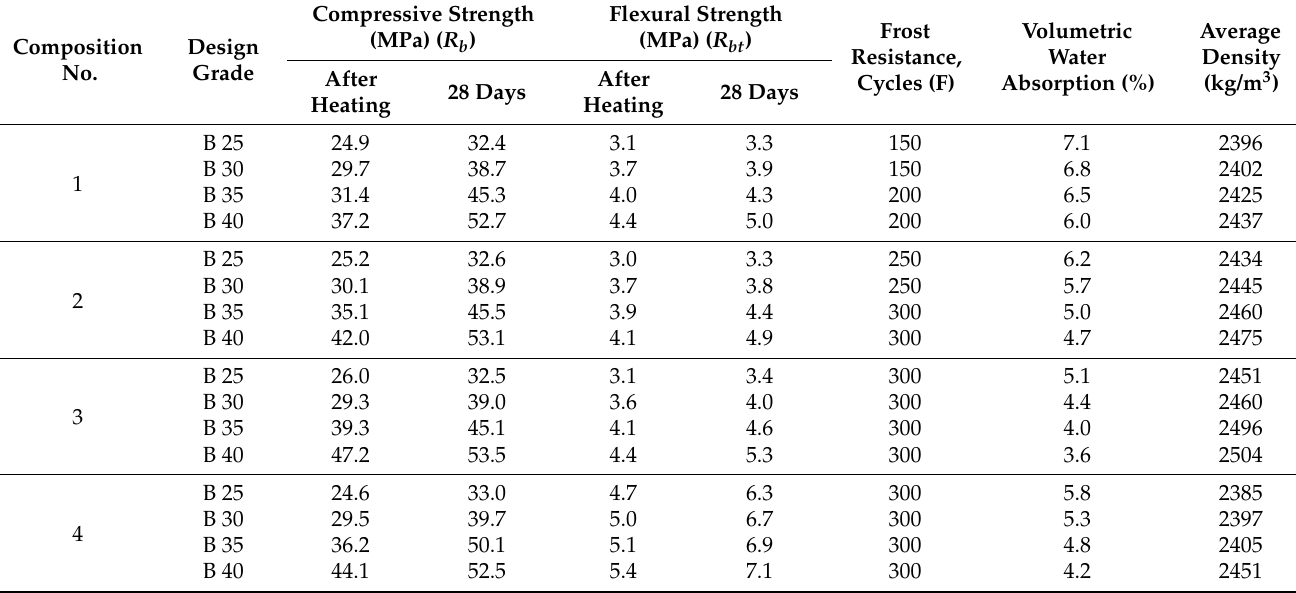
Table 6. Physical and mechanical properties of concrete